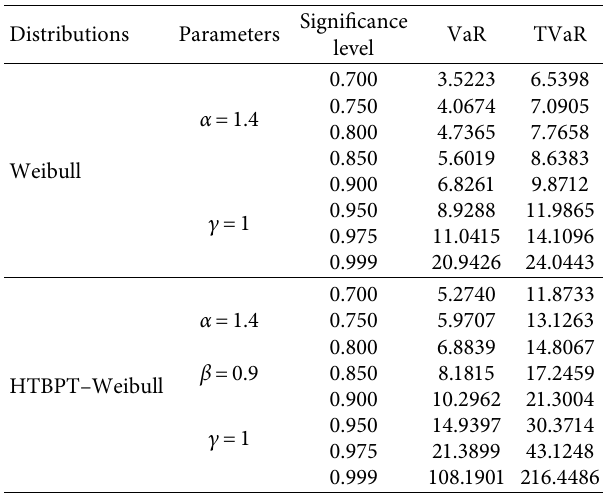
Table 5: For n � 100, the simulation study of the risk measures for Weibull and HTBPT–Weibull